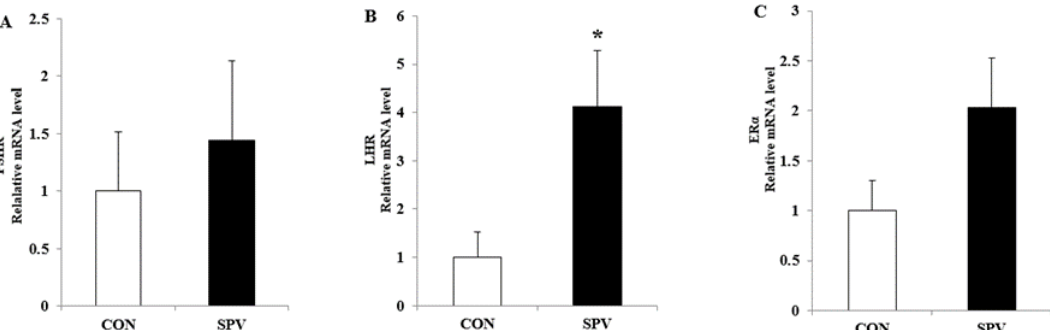
Figure 2. Effect of sweet potato vine supplementation on hormone receptor relative genes’ mRNA expression in the granulosa cells ( n = 10). Data are presented as mean ± SEM. CON, gilts feed the basal diet; SPV, gilts fed basal diet with sweet potato vine. FSHR , follicle-stimulating hormone receptor; LHR , luteinizing hormone receptor; ERα , estrogen receptor- α. * p ≤ 0.05 .